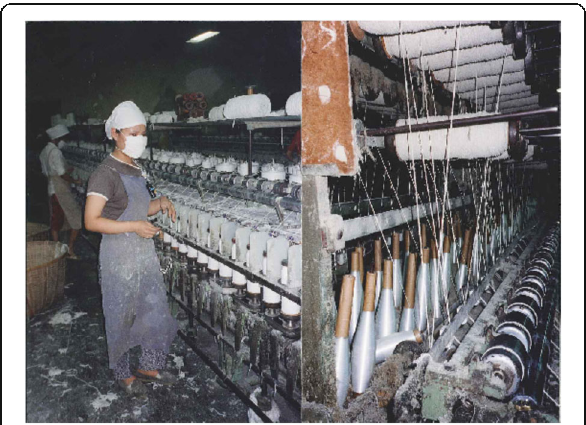
Fig. 2 Roving (left) and spinning (right)